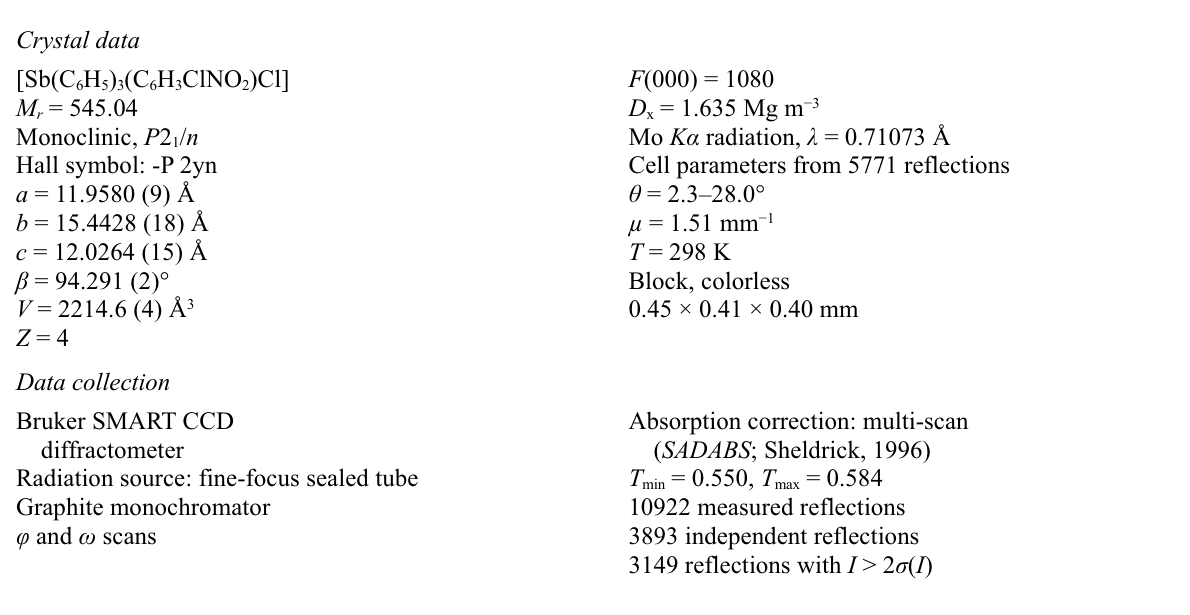
Figure 2 A dimer linked by C20—H20···O2 i hydrogen bonds (dashed lines) (symmetry code i: 1 - x ,- y ,1 - z ).